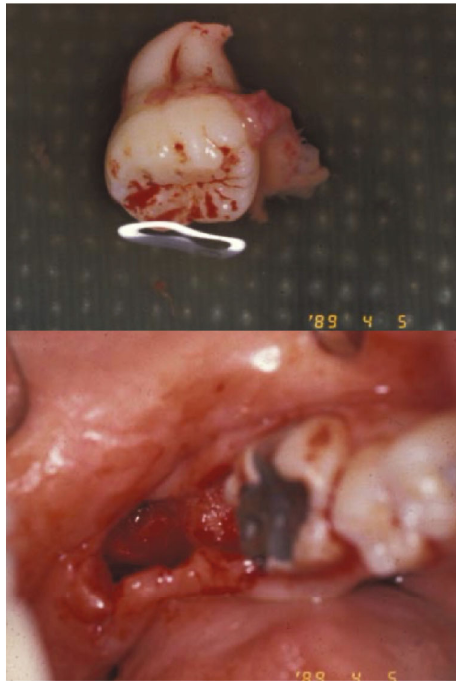
Figure 4: Immediate after of minimal traumatic extractions of #17 and 18. #17 was kept in the saline until this was used.